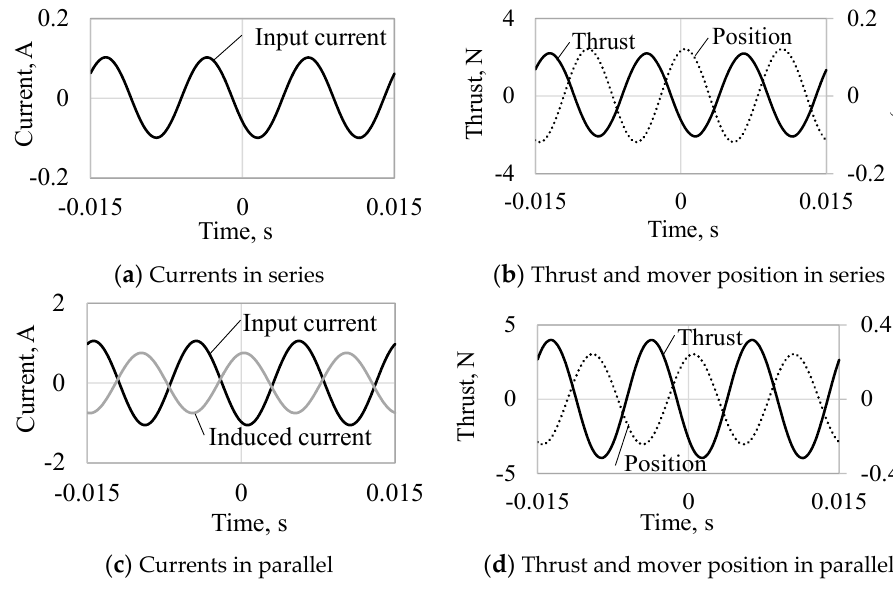
Figure 9. Analyzed results per time variation at 100 Hz.